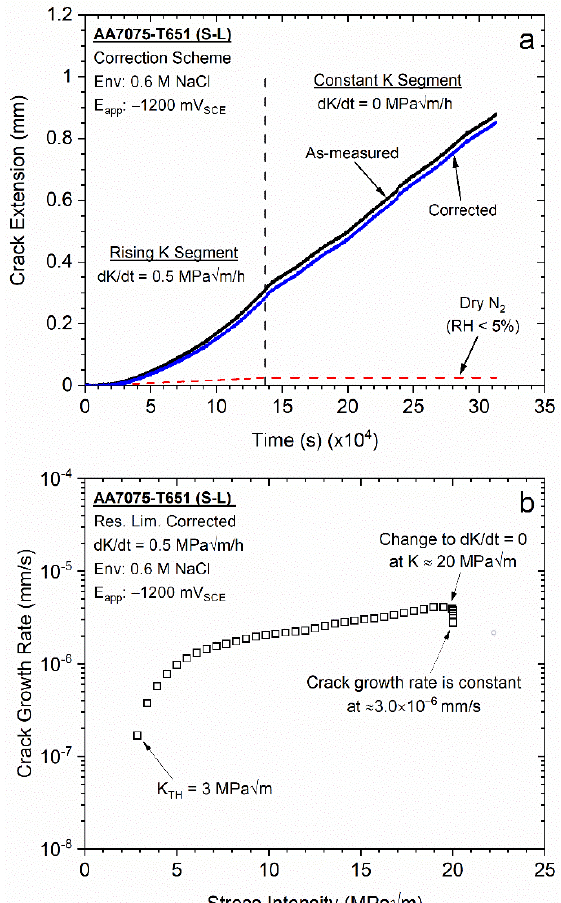
Figure 1. ( a ) Example of the correction procedure utilized to remove the ‘false’ crack extension due to localized plasticity, which is quantified by the apparent crack extension measured in a dry N 2 environment (indicated by red dashed lines). These data can then be differentiated to determine the crack growth rate versus stress intensity relationship, with an example shown in ( b ).